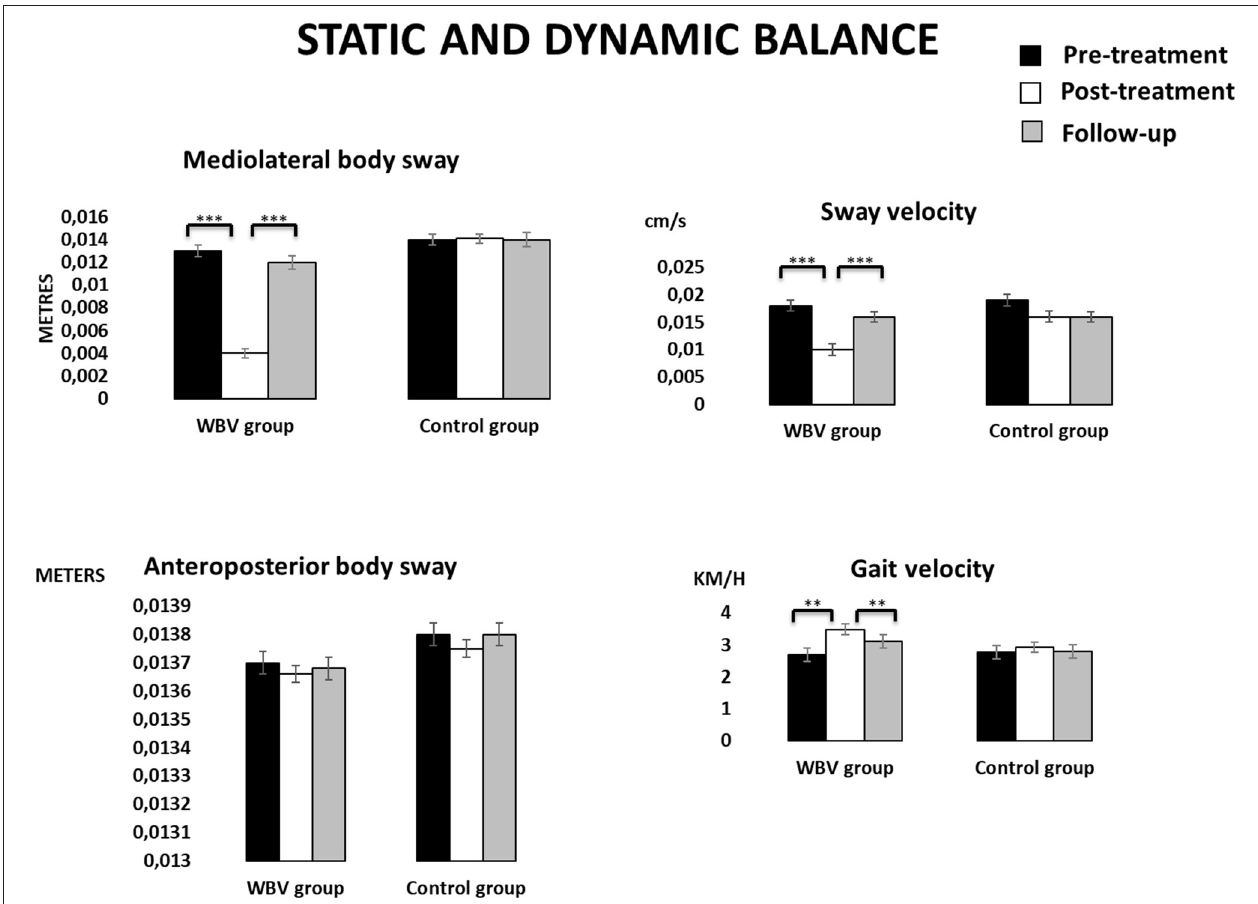
FIGURE 4 | Descriptive data (mean and TE) for the WBV group and the control group in static and dynamic balance at the three assessment times. *** p < 0.001, ** p <